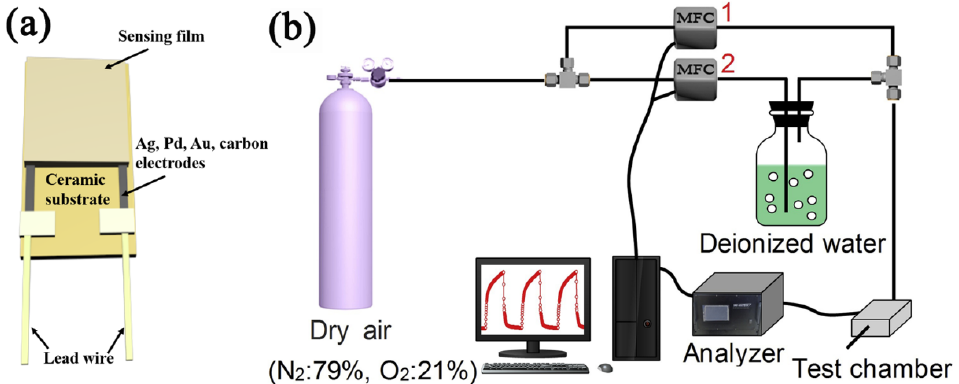
Figure 2. Schematic diagram of ( a ) ceramic − based interdigitated electrode. ( b ) Dynamic air distri- bution system and humidity sensing testing system. Reproduced with permission from Ref. [21].